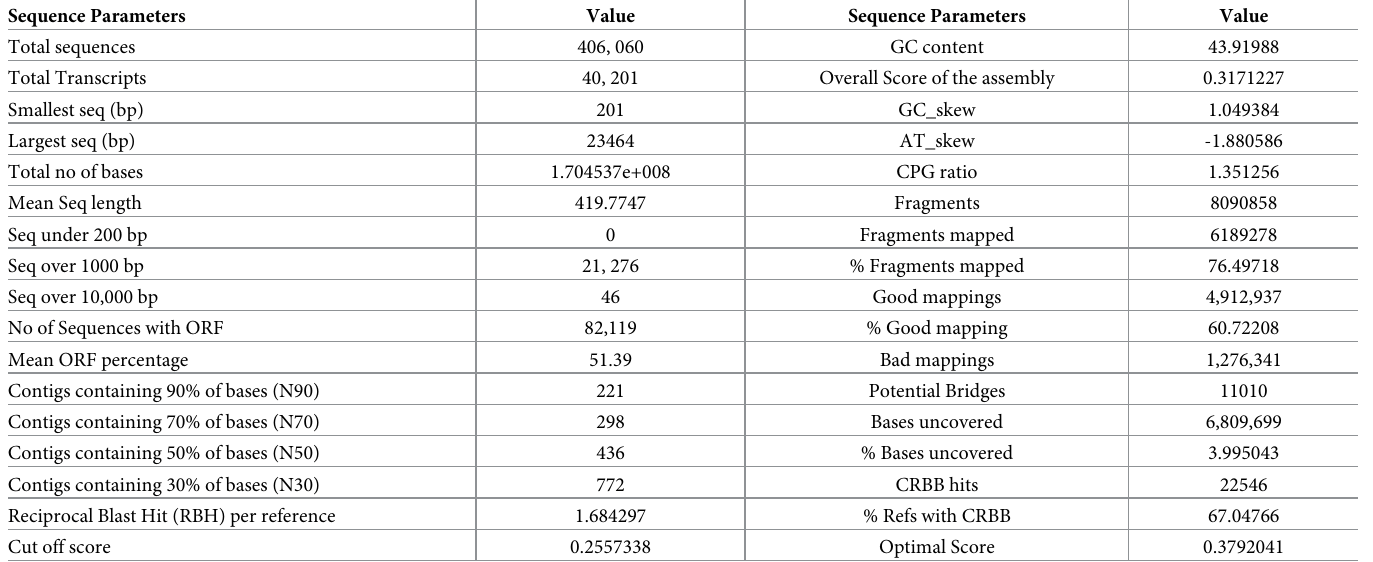
Table 1. Summary of the Nile crocodile de novo transcriptome statistics.